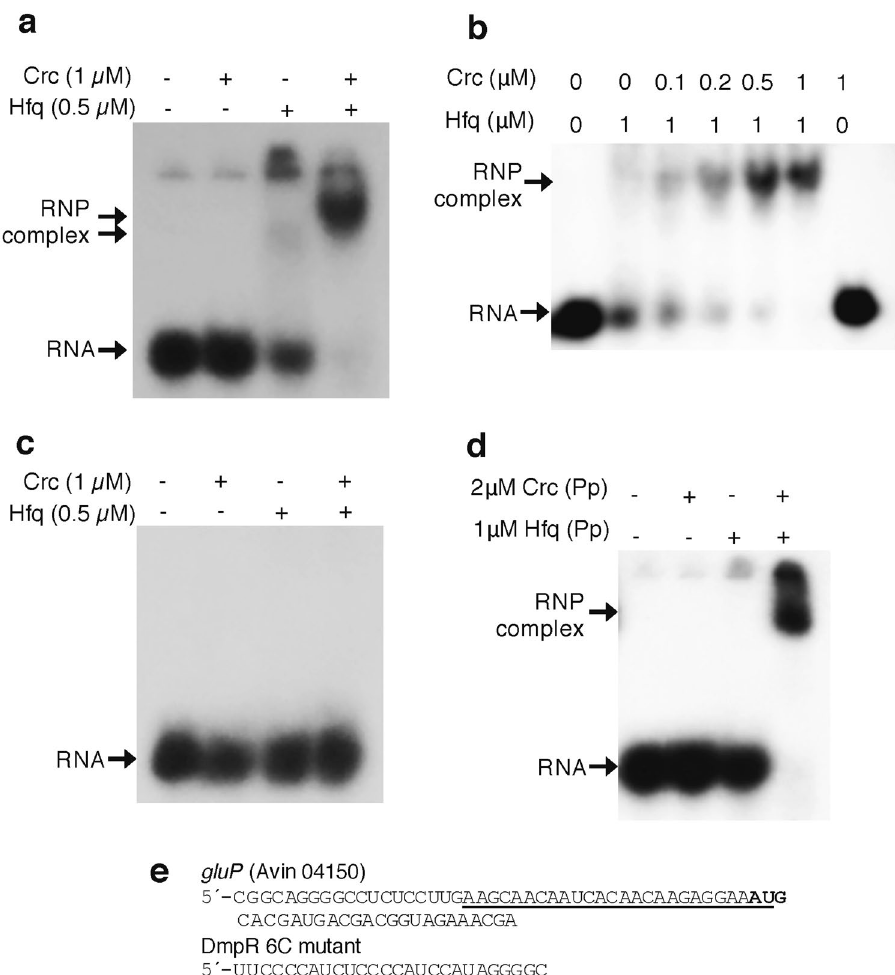
Figure 7. Hfq-Crc proteins form a stable ribonucleoprotein complex with the A-rich Hfq-binding RNA motif of gluP . ( a ) Binding of the A . vinelandii Crc and Hfq proteins to an RNA oligonucleotide containing the A-rich Hfq-binding motif present at the translation initiation region from gluP . ( b ) Molar ratio of the A . vinelandii Crc and Hfq proteins needed to form a ribonucleoprotein complex with the RNA containing the A-rich Hfq- binding gluP motif. As a control an RNA oligonucleotide lacking an A-rich motif was used ( c ). ( d ) Binding of the P . putida (Pp) Crc and Hfq proteins to the RNA A-rich Hfq binding motif of gluP . RNA and protein-RNA complexes were resolved in a non-denaturing polyacrilamide gel. The concentration of Crc (expressed as monomers) and Hfq (expressed as hexamers) is indicated. Arrows point to the position of free RNA and of the ribonucleoprotein complex (RNP). ( e ) Sequence of the gluP mRNA leader region. The underlined sequence corresponds to the RNA oligonucleotide used in the band-shift assays, which contains the A-rich motif. The AUG translation initiation codon is in bold face. The sequence of the oligonucleotide used as control in panel ( c ), named DmpR 6C, is also